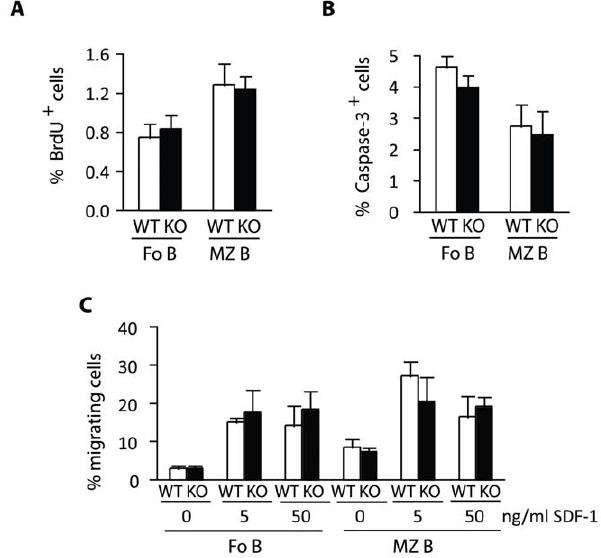
Figure 8. Normal proliferation and apoptosis levels in Eps15- KO MZ B cells. A.–B. Bar graph depicting the percentage of BrdU- positive (BrdU + ) ( A ) or active caspase-3-positive (Caspase + ) ( B ) in Fo and MZ B cells in 2 2 4-month-old Eps15-WT (WT, white bars) and Eps15- KO (KO, black bars) mice 4 hrs after a BrdU pulse (n=8). C. Bar graph depicting the percentage of Fo and MZ B cells migrating towards increasing concentrations of the chemokine SDF-1 in a transwell assay using purified splenic B cells from 3-month-old Eps15-WT (WT, white bars) and Eps15-KO (KO, black bars) mice (n=4).